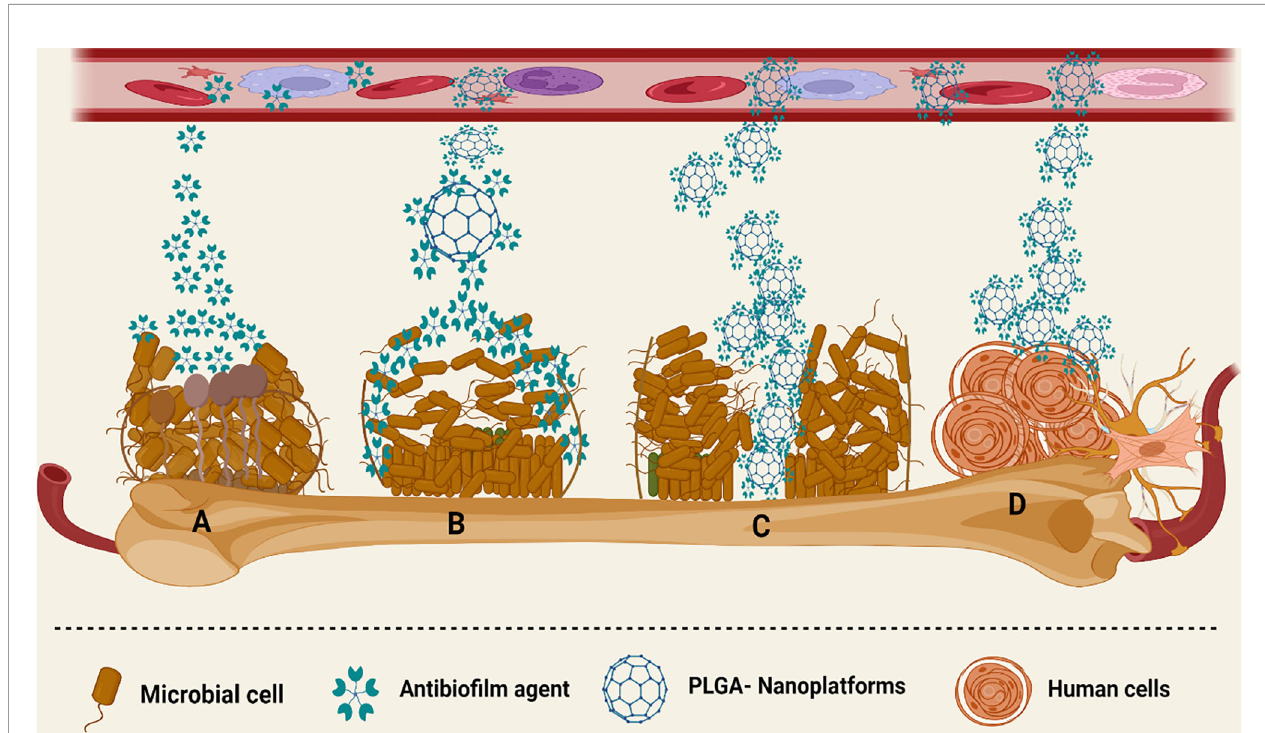
FIGURE 5 | Different interactions of PLGA-based nanoplatforms with the microbial bio fi lm structure. (A) Anti-bio fi lm agents have limited activity against the bio fi lm community of microorganisms. (B) PLGA platforms release antibiotics in a sustained manner and boost the anti-bio fi lm agent ’ s site-speci fi c delivery, as well as enhance their concentration in the microbial bio fi lm community. (C) PLGA increased the penetration of various anti-bio fi lm agents to the mucus and deeper layers of the bio fi lm. (D) PLGA has low cytotoxic effects on various human